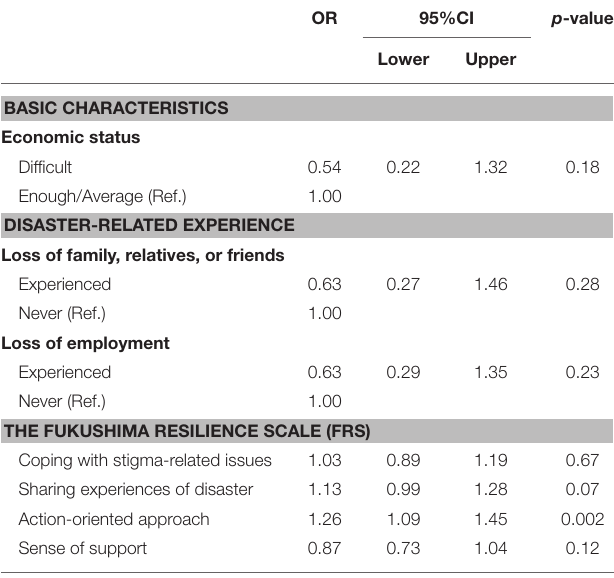
TABLE 4 | Multivariable logistic regression analysis between K6 score and related